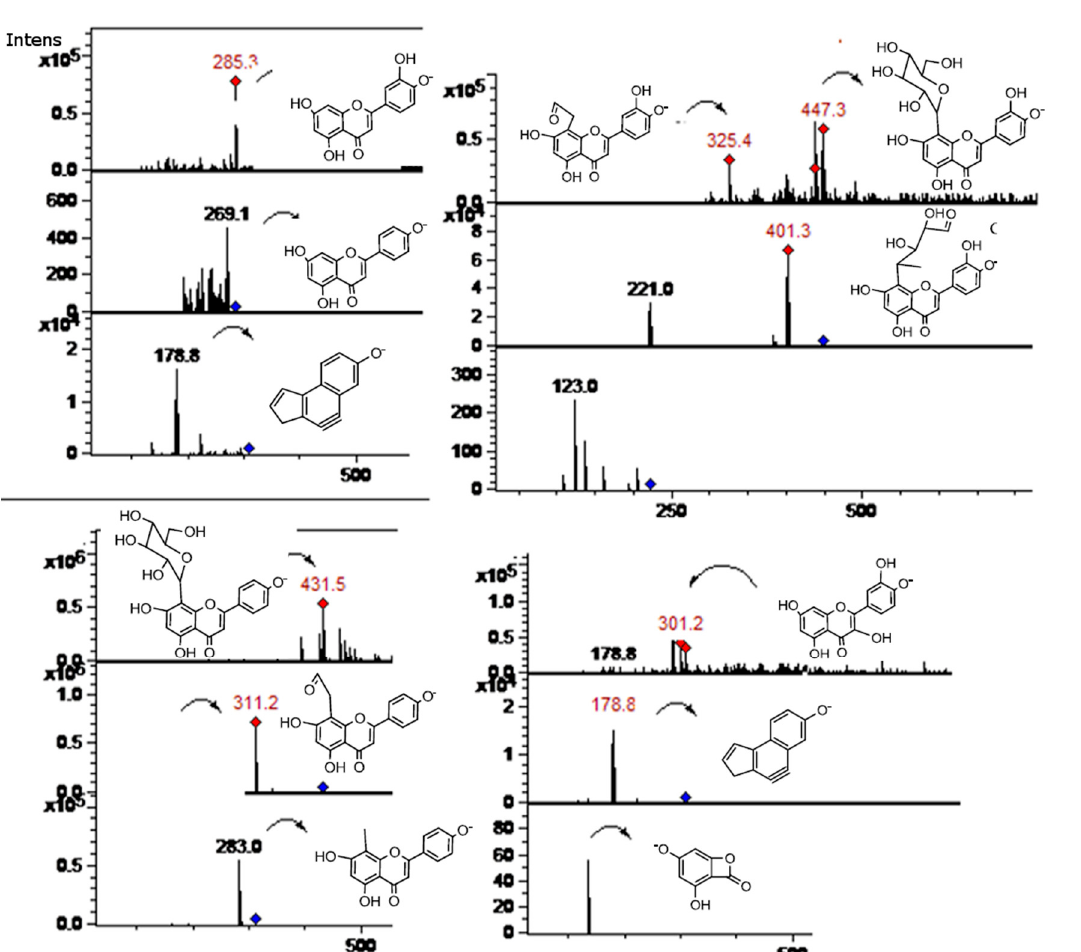
Figure 8. MS spectra of peaks 27 , 36 , and 37 . (Refer to Table